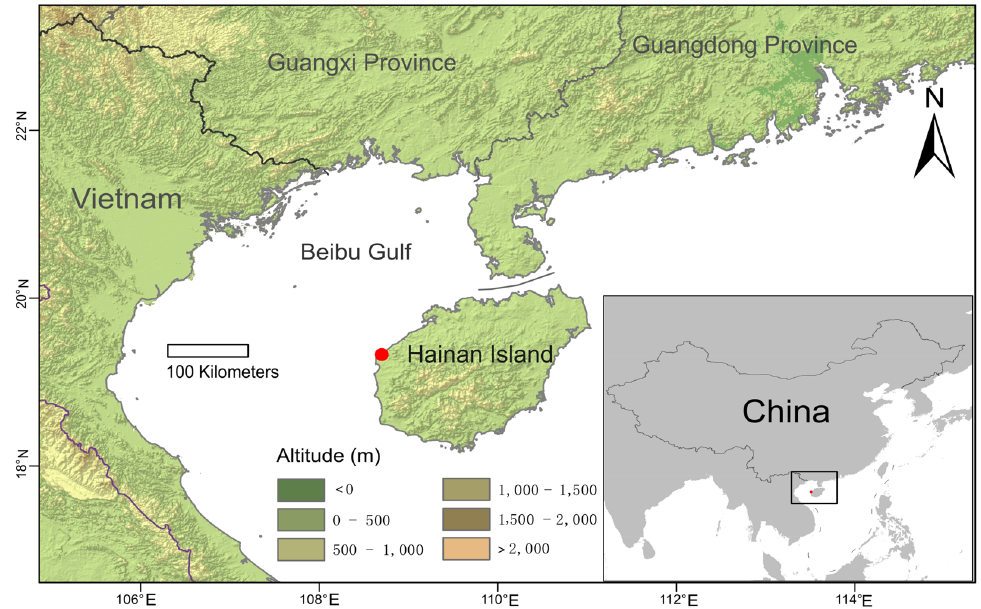
Figure 1. Distribution map of Selaginella iridescens . The red dot represents the location of S. iridescens . The color scale indicates the elevation in the meters above sea level as recorded in the raster layers of 30 s resolution of the NASA Shuttle Radar topographic Mission (SRTM)